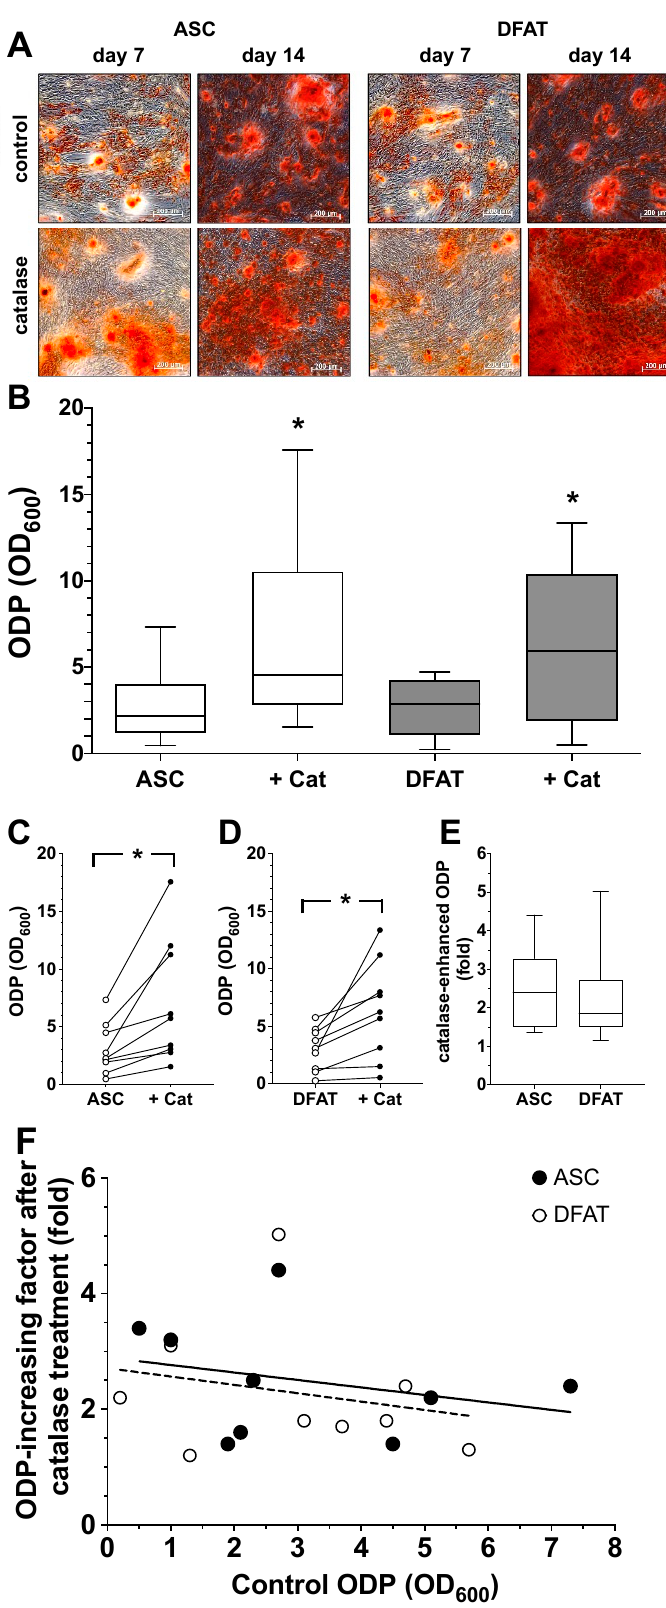
Figure 5. Impact of catalase on osteogenic differentiation potential of ASC and DFAT cultures obtained from the same adipose tissue. ( A ) Alizarin Red stain of osteogenically activated ASC and DFAT cultures at day 7 and day 14 of differentiation (control) and respective cell cultures